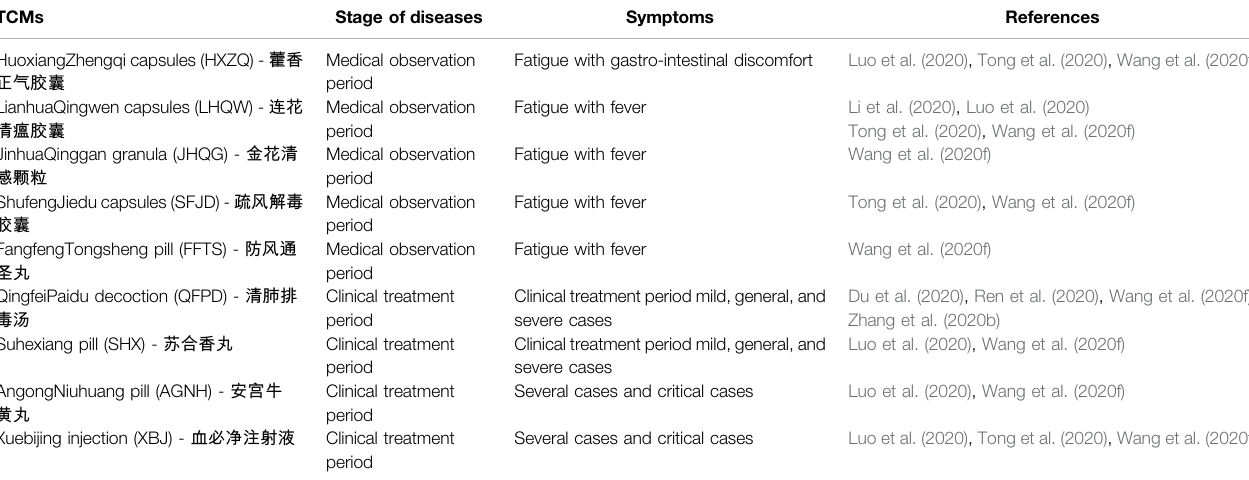
TABLE 2 | Nine TCMs recommended by guidelines of treatment for COVID-19.